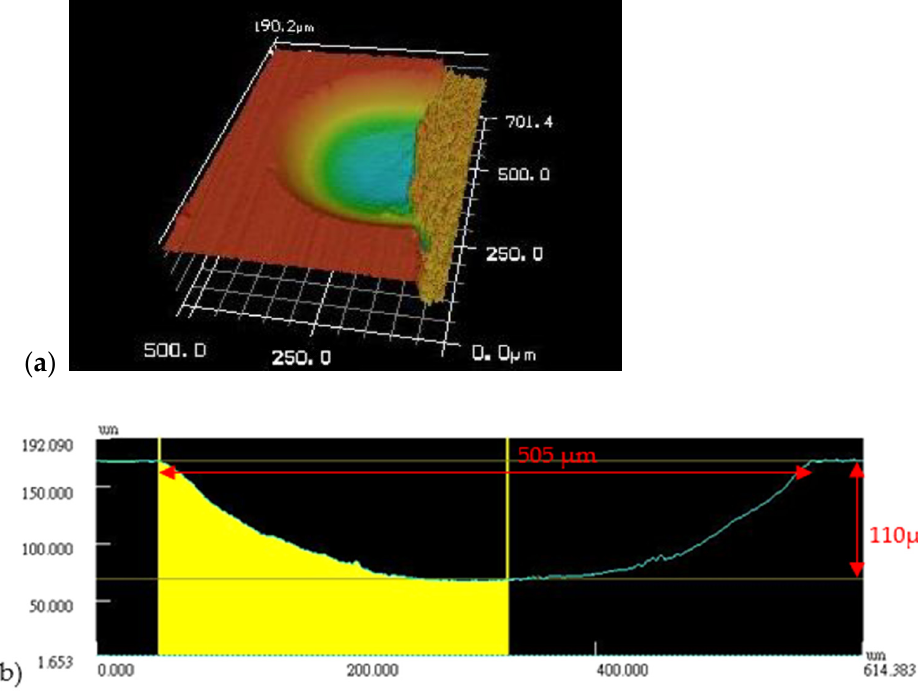
Figure 14. ECM milling of a deep slot in ( a ) 3D morphology and ( b ) profile of its cross-section over its width